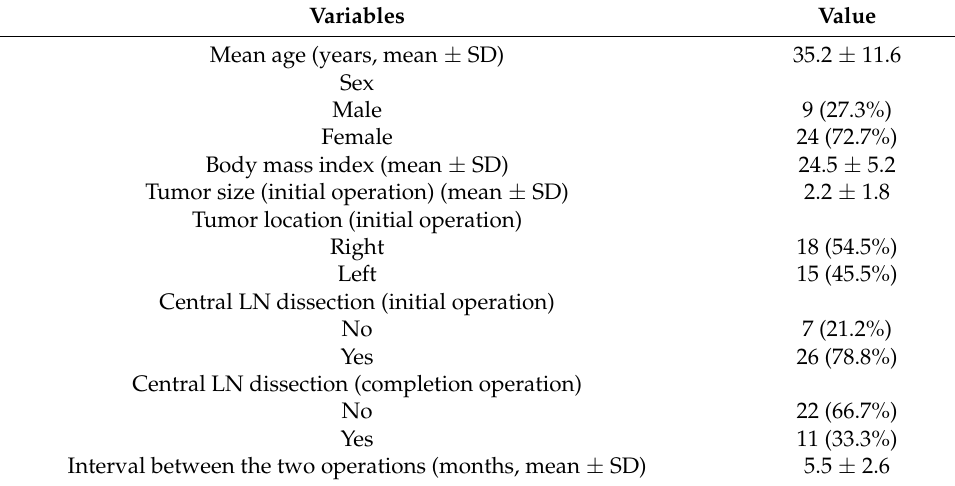
Table 1. Patient baseline characteristics.